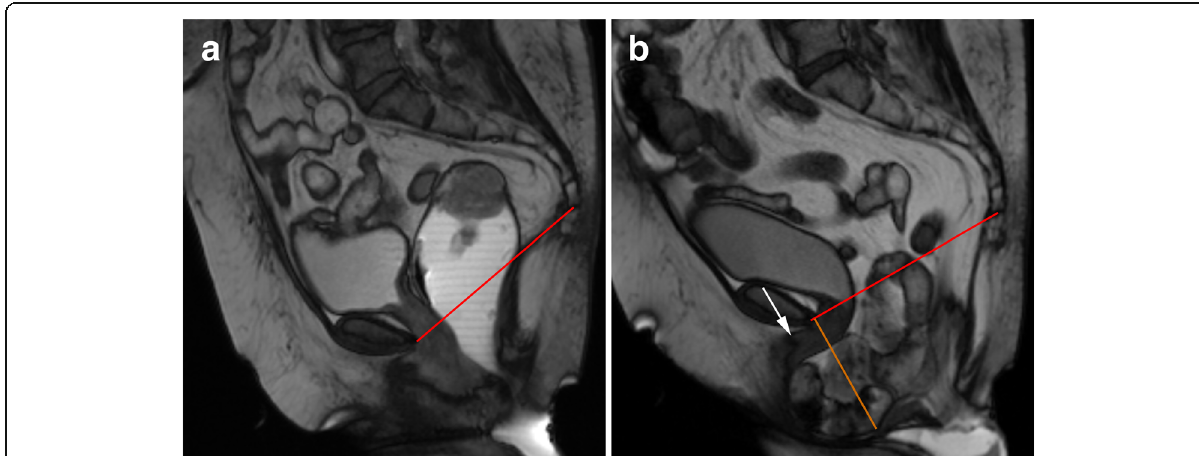
Fig. 16 Severe enterocele with vaginal vault prolapse, urethral hypermobility and urinary obstruction. ( a , b ) Sagittal midline TrueFISP images at rest ( a ) and during evacuation ( b ) of a patient previously submitted to hysterectomy, showing an enterocele. Note the herniation of small bowel loops into the rectovaginal septum. It is difficult to identify correctly the vaginal apex, but it is clear it is located below the PCL (red line), corresponding to a vaginal vault prolapse. The volume of the enterocele is so large that its mass effect over the vagina and urethra pushes them anteriorly, inducing also an horizontalization of their normal vertical axis — urethral hypermobility (white arrow) — and inducing obstruction of the bladder (the urinary volume of the bladder on both phases is similar, always above the PCL). Note also that the bladder is more distended than it should be. Although not relevant for this specific case, the bladder should be half distended, as preconized by the ESUR/ESGAR recommendations. Orange line : extent of the